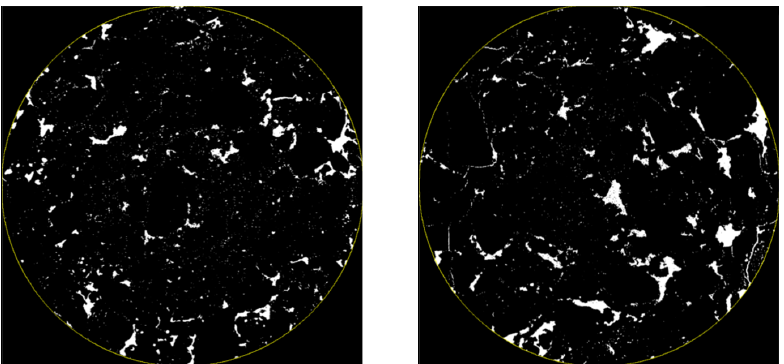
Figure 18. The distribution maps of voids and cracks before and after middle splitting of the specimen.